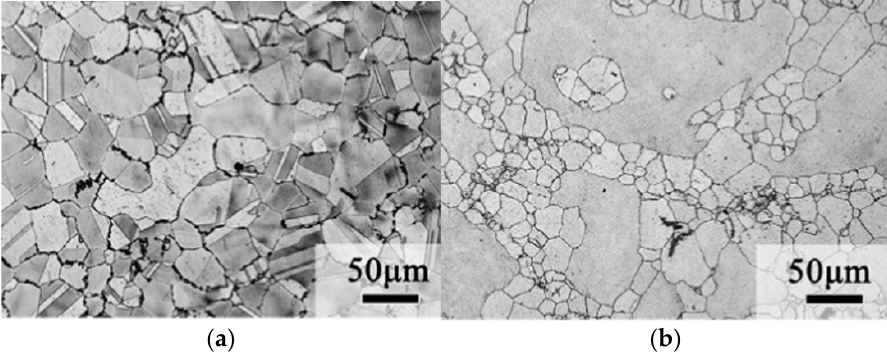
Figure 6. Structure of the extruded Cu–9Ni–2.5Sn–xSi alloy as shown by an optical microscope: ( a ) x = 0; ( b ) x= 0.5 [31] . ( a ) x = 0; ( b ) x= 0.5